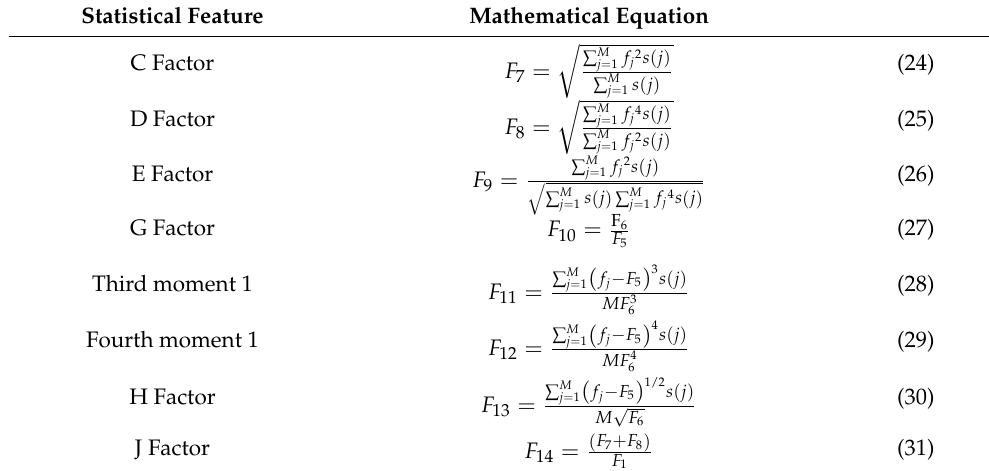
Table 2. Cont. Statistical